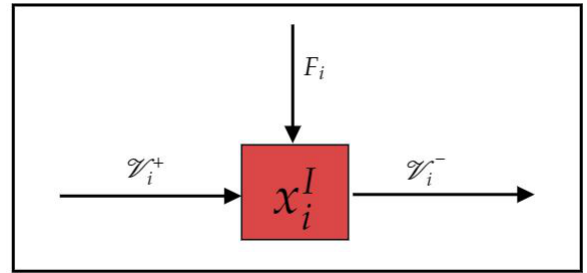
Figure 2. Entering and leaving fluxes related to compartment i